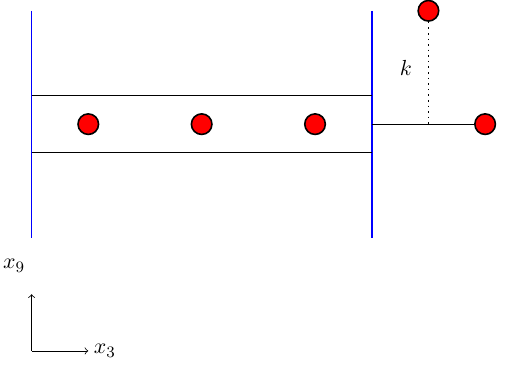
Figure 11 . Type IIB brane construction for a gauge Wilson defect for U(2) in a representation R = S k ⊗ A 2 . The red rectangular nodes denote D5’-branes, while the dotted vertical lines denote F1-strings.